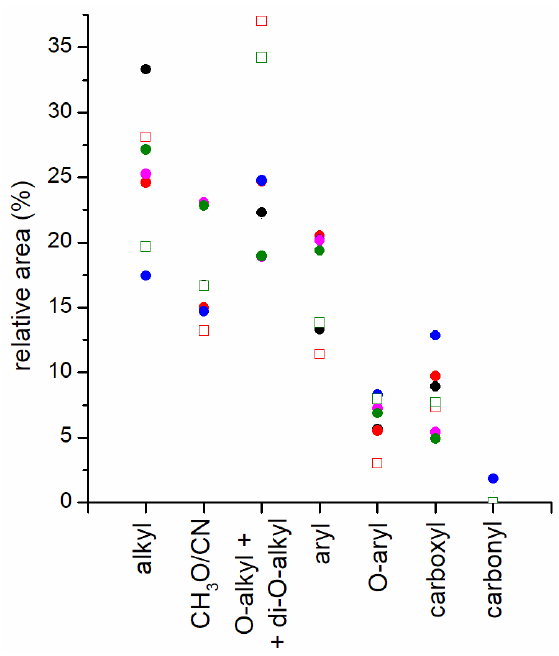
Figure 4. Relative areas of the 13 C NMR spectral regions recorded for CM vermicomposts (squares) and humic extracts of CM vermicomposts (circles) in the following studies: ( ● , □ ) [108], ( ● ) [110], (●) [112], ( ● ) [113], ( ● ) [114], ( □ ) [115].